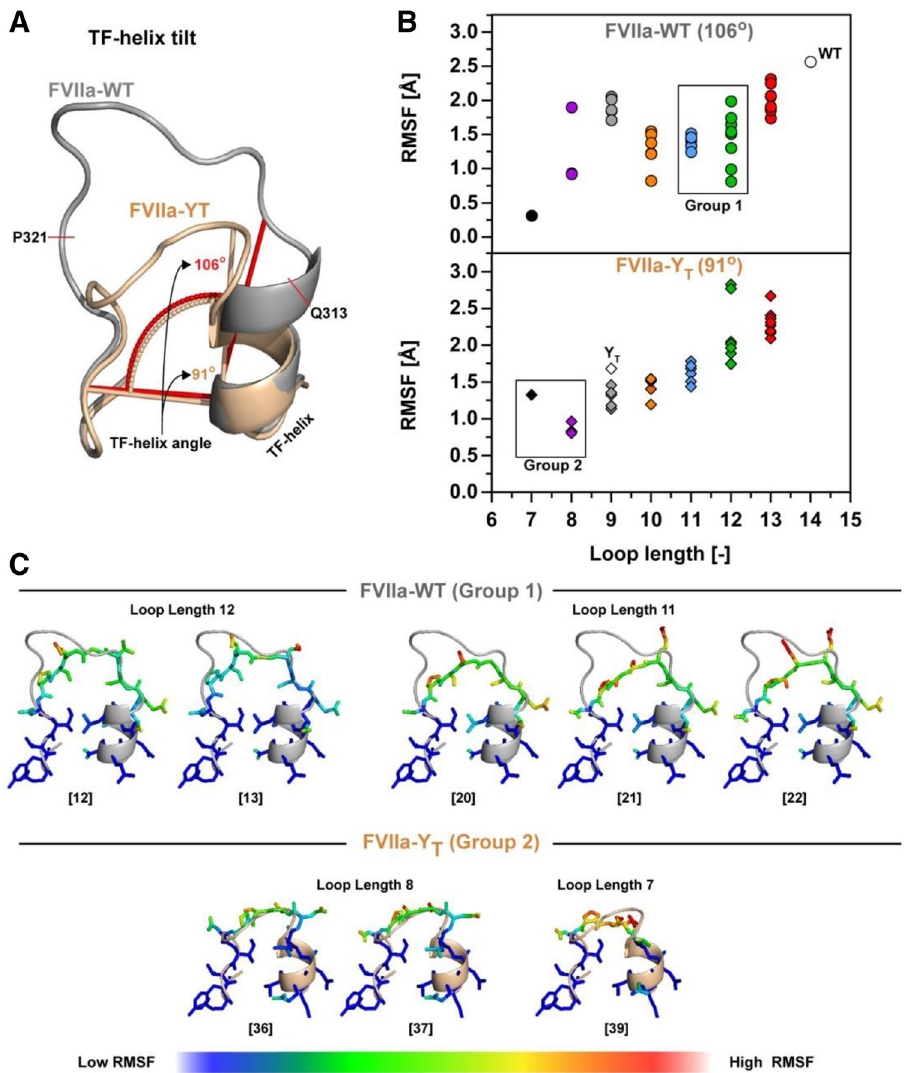
Figure 4. α-helix Angle Determines the Effects of Loop Length on 170 Loop Flexibility. ( A ) Orientation of the TF-helix as defined by the angle between the bottom of the 170 loop and the outer left side of the TF-helix in FVIIa (PDB ID 1dan, grey) and FVIIa-Y T (PDB ID 4z6a, wheat) Q313{c170A} to P321{c170I} was rebuild using the Rosetta NGK protocol. ( B ) Average RMSF for all atoms rebuild in Rosetta with remaining loop lengths colour coded as red (13), green (12), blue (11), orange (10), grey (9), purple (8) and black (7). ( C ) Group 1 and group 2 FVIIa variants build using Rosetta Generalized Kinematic Closure (see supplemental Fig. S3 and S5 for all 39 variants). The root-mean-square fluctuation (RMSF) is defined around the shown geometric mean (N = 250) with low values shown in blue and high values in